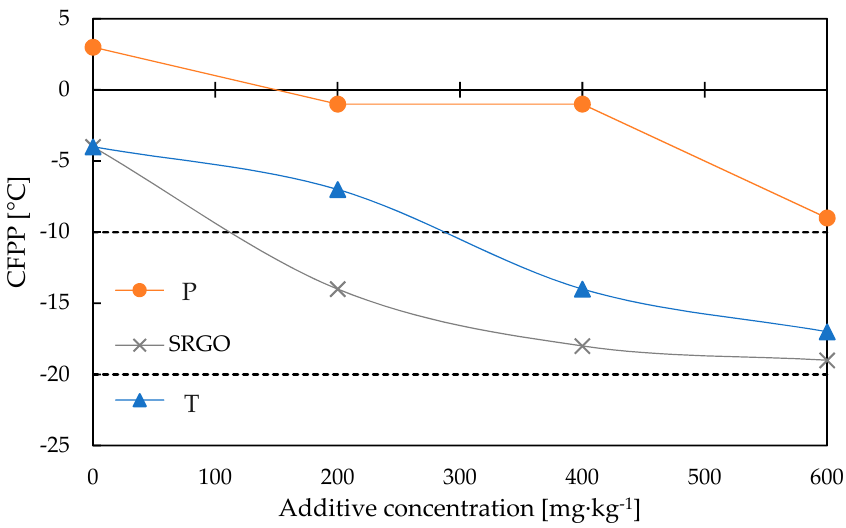
Figure 6. Dependence of the CFPP value on the additive concentration (dashed lines represent the limits of Č SN EN 590 for the transitional diesel ( − 10 °C) and winter ( − 20 °C)).